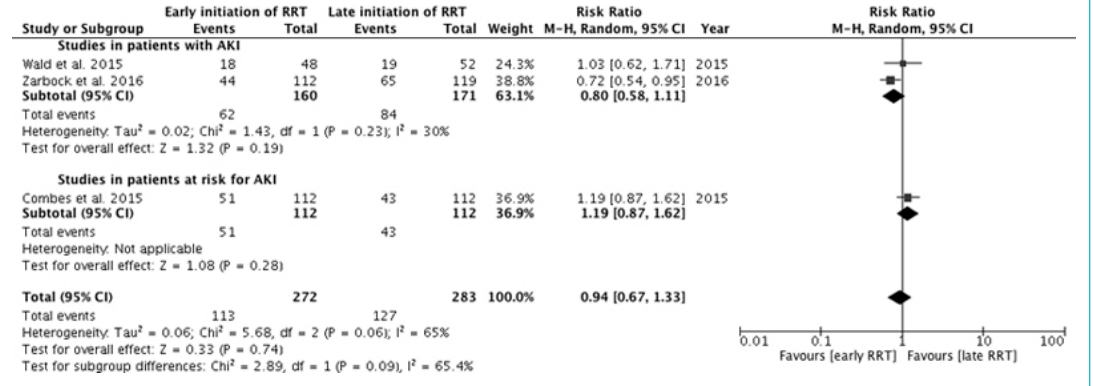
Figure S4: 90-day mortality. Forest plot demonstrating the impact of early or preventive renal replacement therapy on 90-day mortality com- pared with late renal replacement therapy. Data are presented as risk ratios with 95% confidence intervals. A random-effects model was